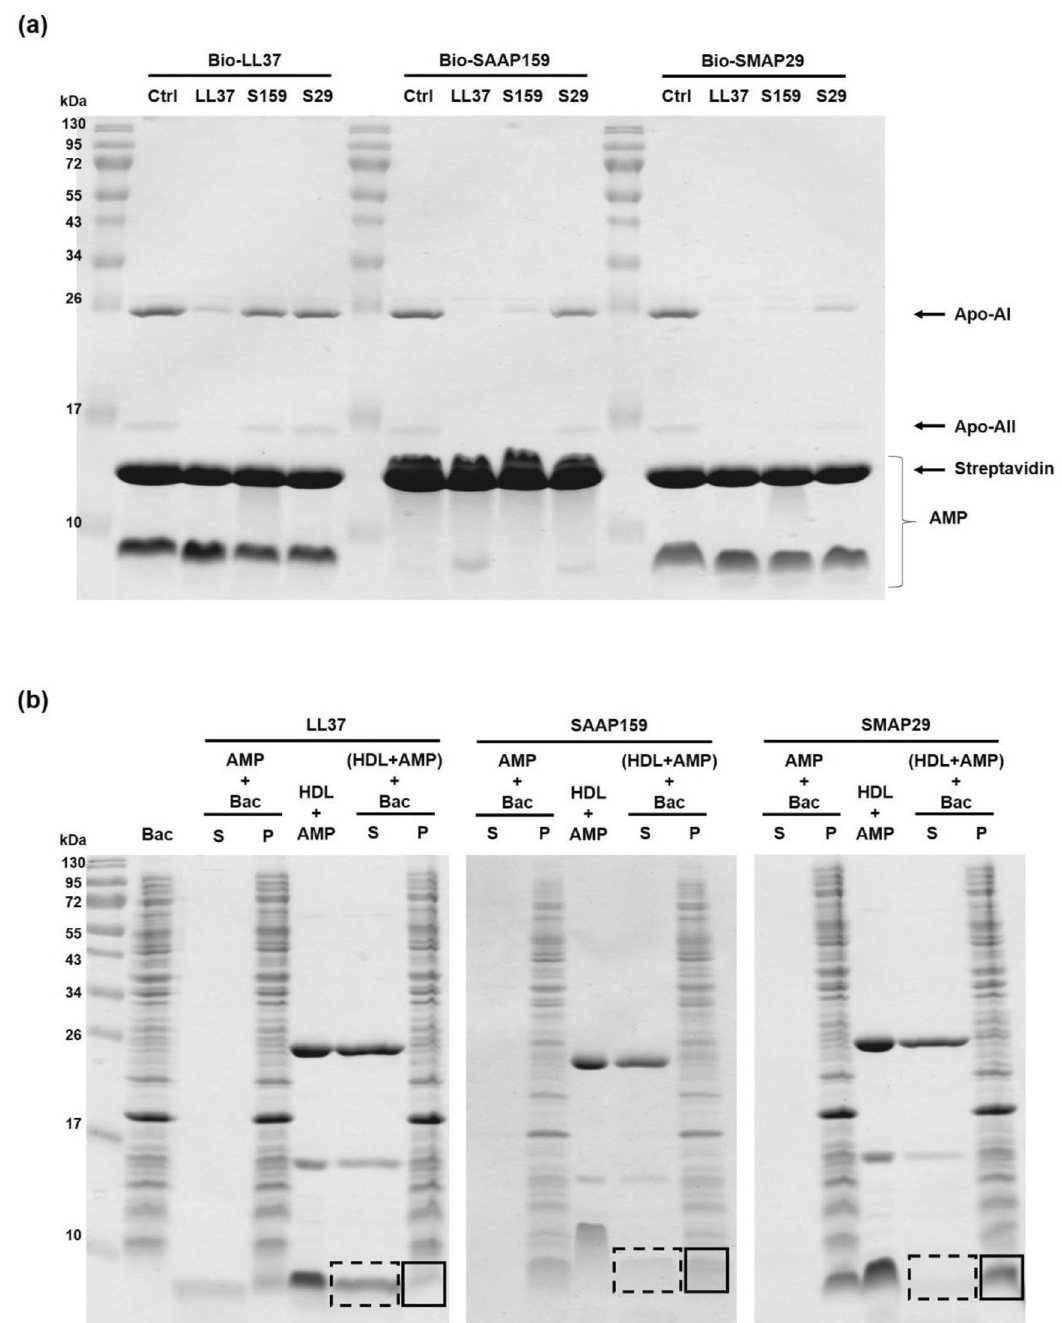
Figure 6. Translocation of AMP from HDL-AMP complex to bacteria. ( a ) Dynamic binding between HDL and AMP. HDL was pulled down by immobilized AMPs, then incubated with twofold amount of free AMP for 30 min at 25 °C. The residual proteins remained on the beads were analyzed by 15% non-reducing SDS-PAGE. ( b ) Translocation of AMP to bacteria. The AMP (2.5 µg) alone or in complex with HDL (5 µg) was incubated with E. coli (10 8 cfu) for 5 min at 25 °C before centrifugation. The proteins in the supernatant (S) and pellet (P) were analyzed by 15% non-reducing SDS-PAGE and Coomassie blue staining. The AMPs translocated to bacteria or remained in soluble complex were shown in solid and dotted lines,